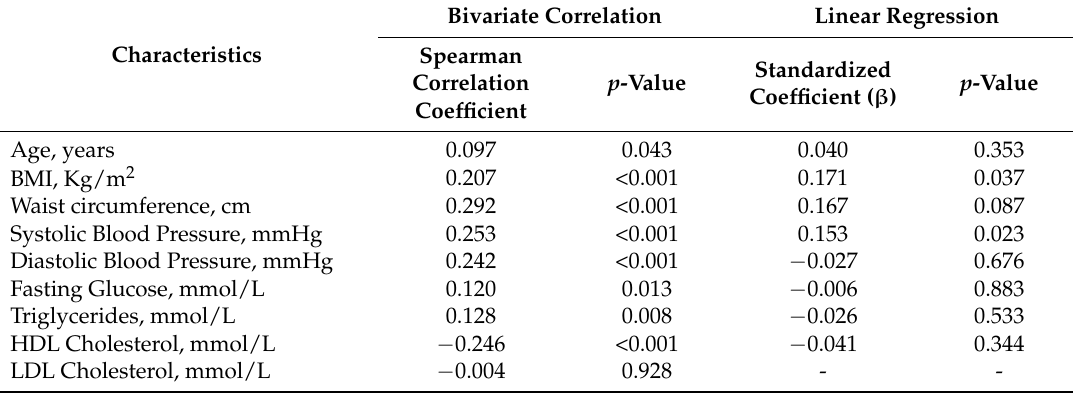
Table 2. Univariate and multivariate predictors of left ventricular (LV) mass index.